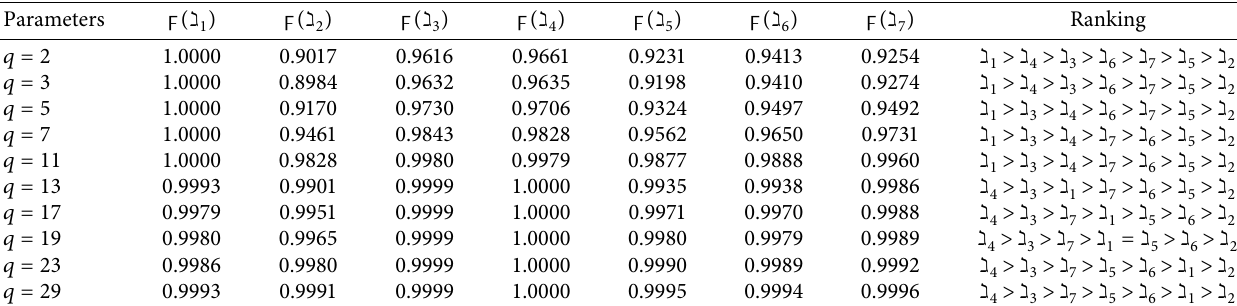
Table 13: Score values and ranking outcomes according to the parameter q by the 2TLC q -ROFHWG operator. Parameters